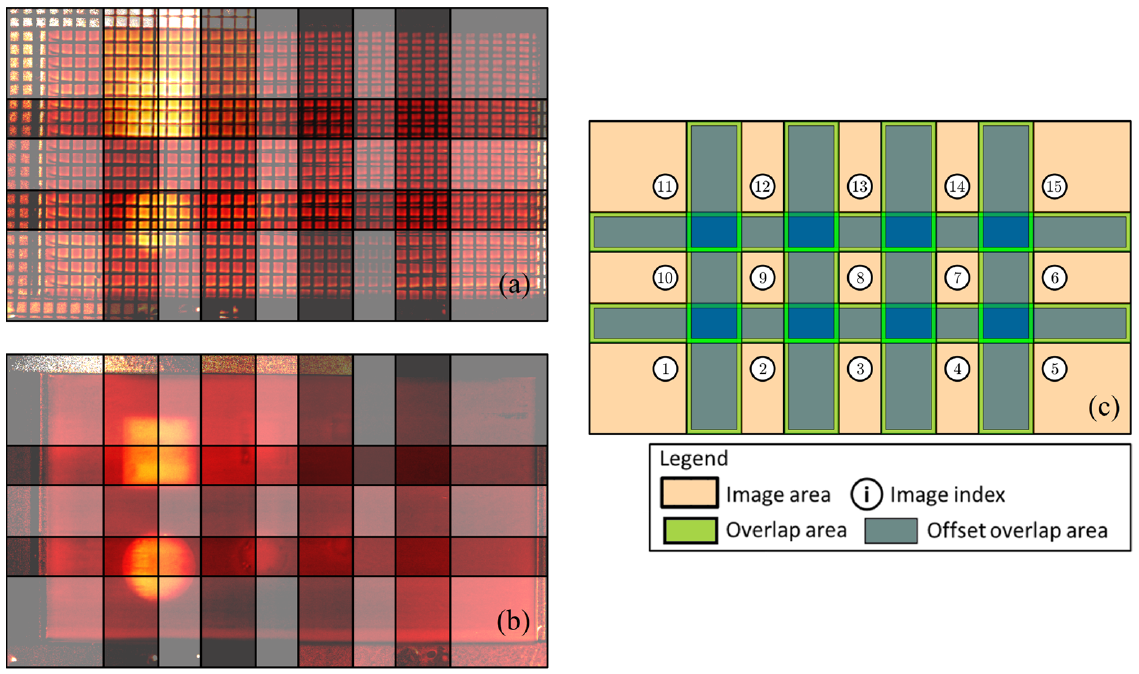
which is the case for the sets of images at hand.